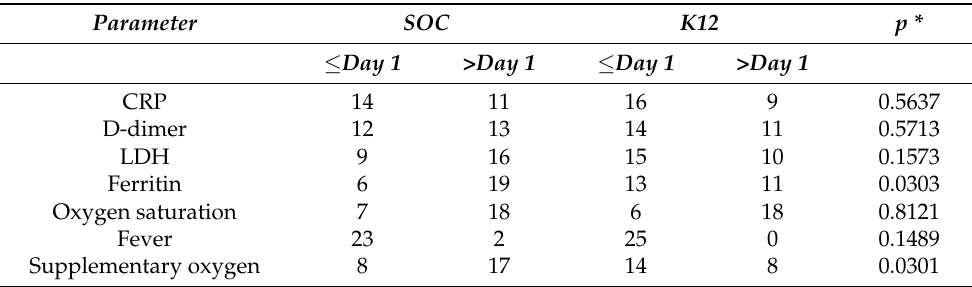
Table 5. Number of patients with a value ≤ or > than the one observed at